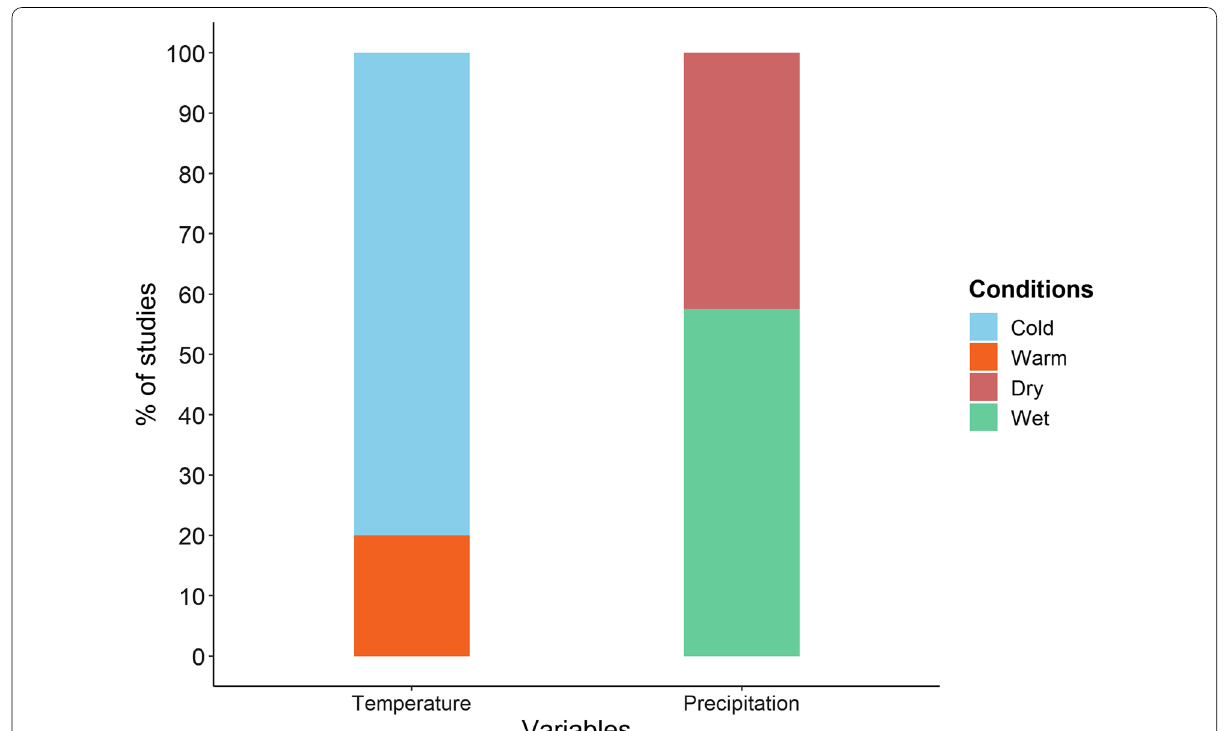
Fig. 6 Relationship of temperature and precipitation during the Younger Dryas. The number of studies used for the warm/cold or wet/dry conditions can be found in Table